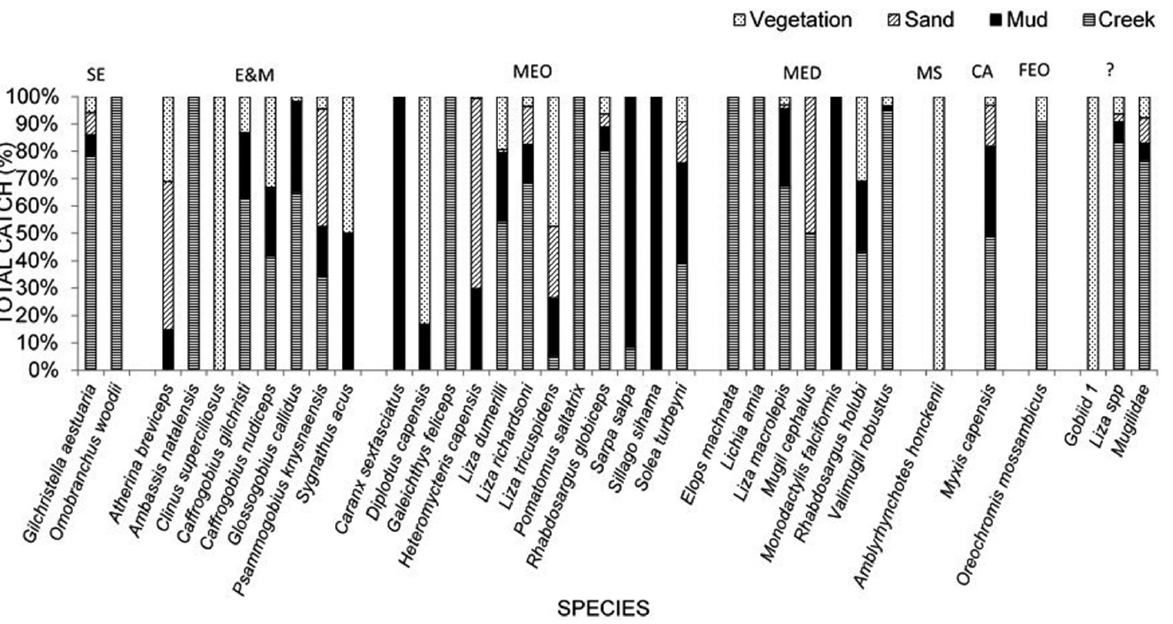
Fig. 3. – Percentage contribution of each habitat to total catch by the large-mesh seine net for each species grouped by estuary association (Pot- ter et al. 2015) in the Swartkops Estuary (February 2013 - January 2014). SE, solely estuarine species; E&M, estuarine and marine species; MEO, marine migrant estuarine opportunists; MED, marine migrant estuarine dependent: MS, marine stragglers; CA, catadromous; FEO, freshwater estuarine opportunists; ?,